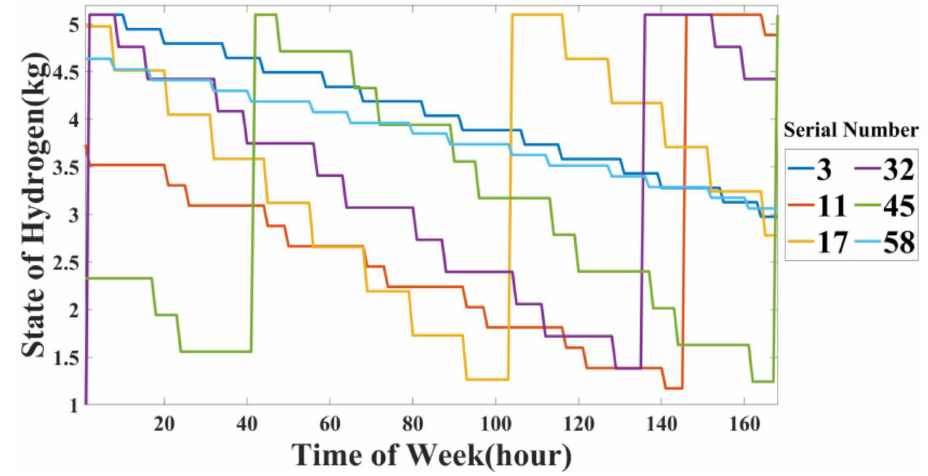
Figure 3. Daily consumption and refueling behaviors of hydrogen cars.